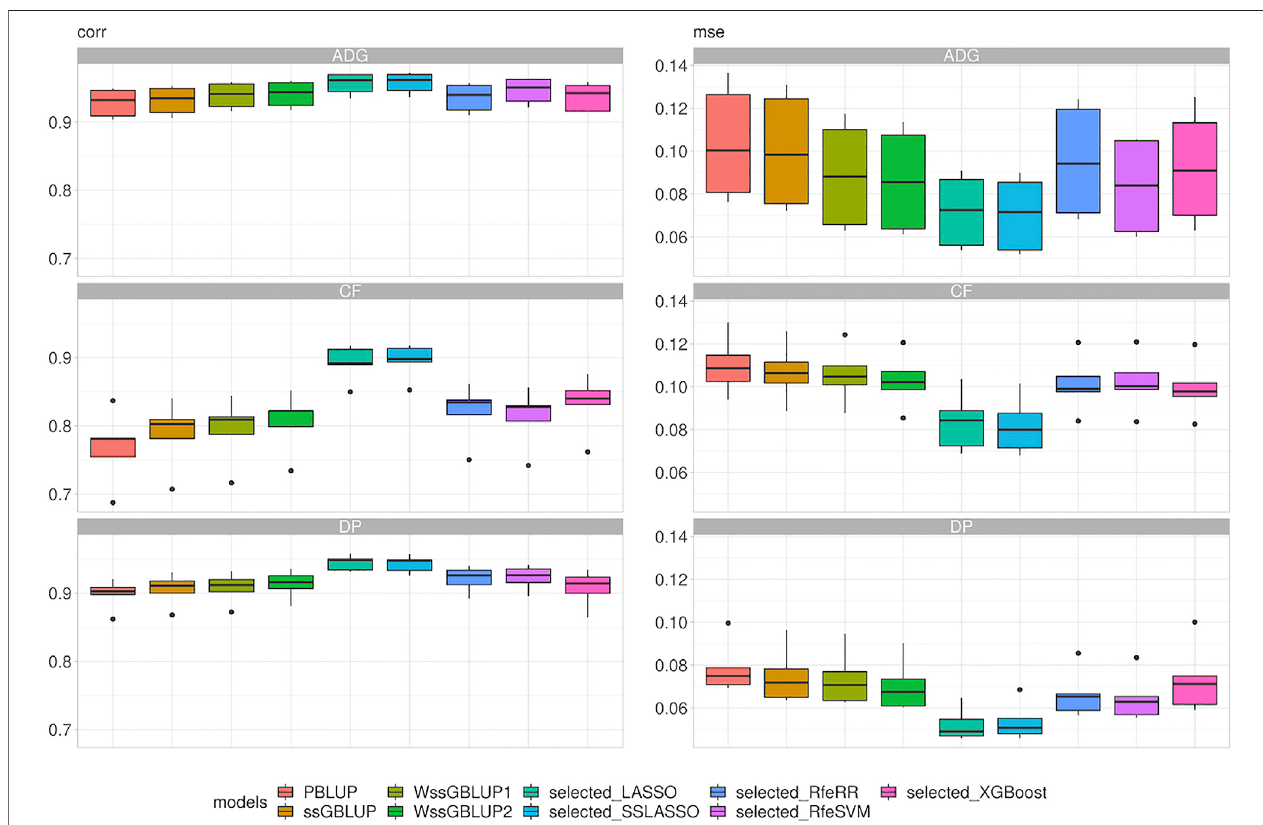
FIGURE 7 | Box plot representing correlation (corr) and mean squared error (MSE) between predicted and true breeding values of phenotypes recorded in Rendena performance testing stations. Target phenotypes are ADG: average daily gain; CF: in vivo carcass fl eshiness; DP: in vivo dressing percentage.